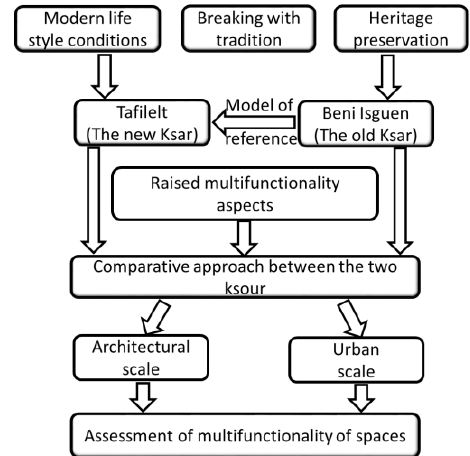
Figure 1. Structure of the Study (Developed by